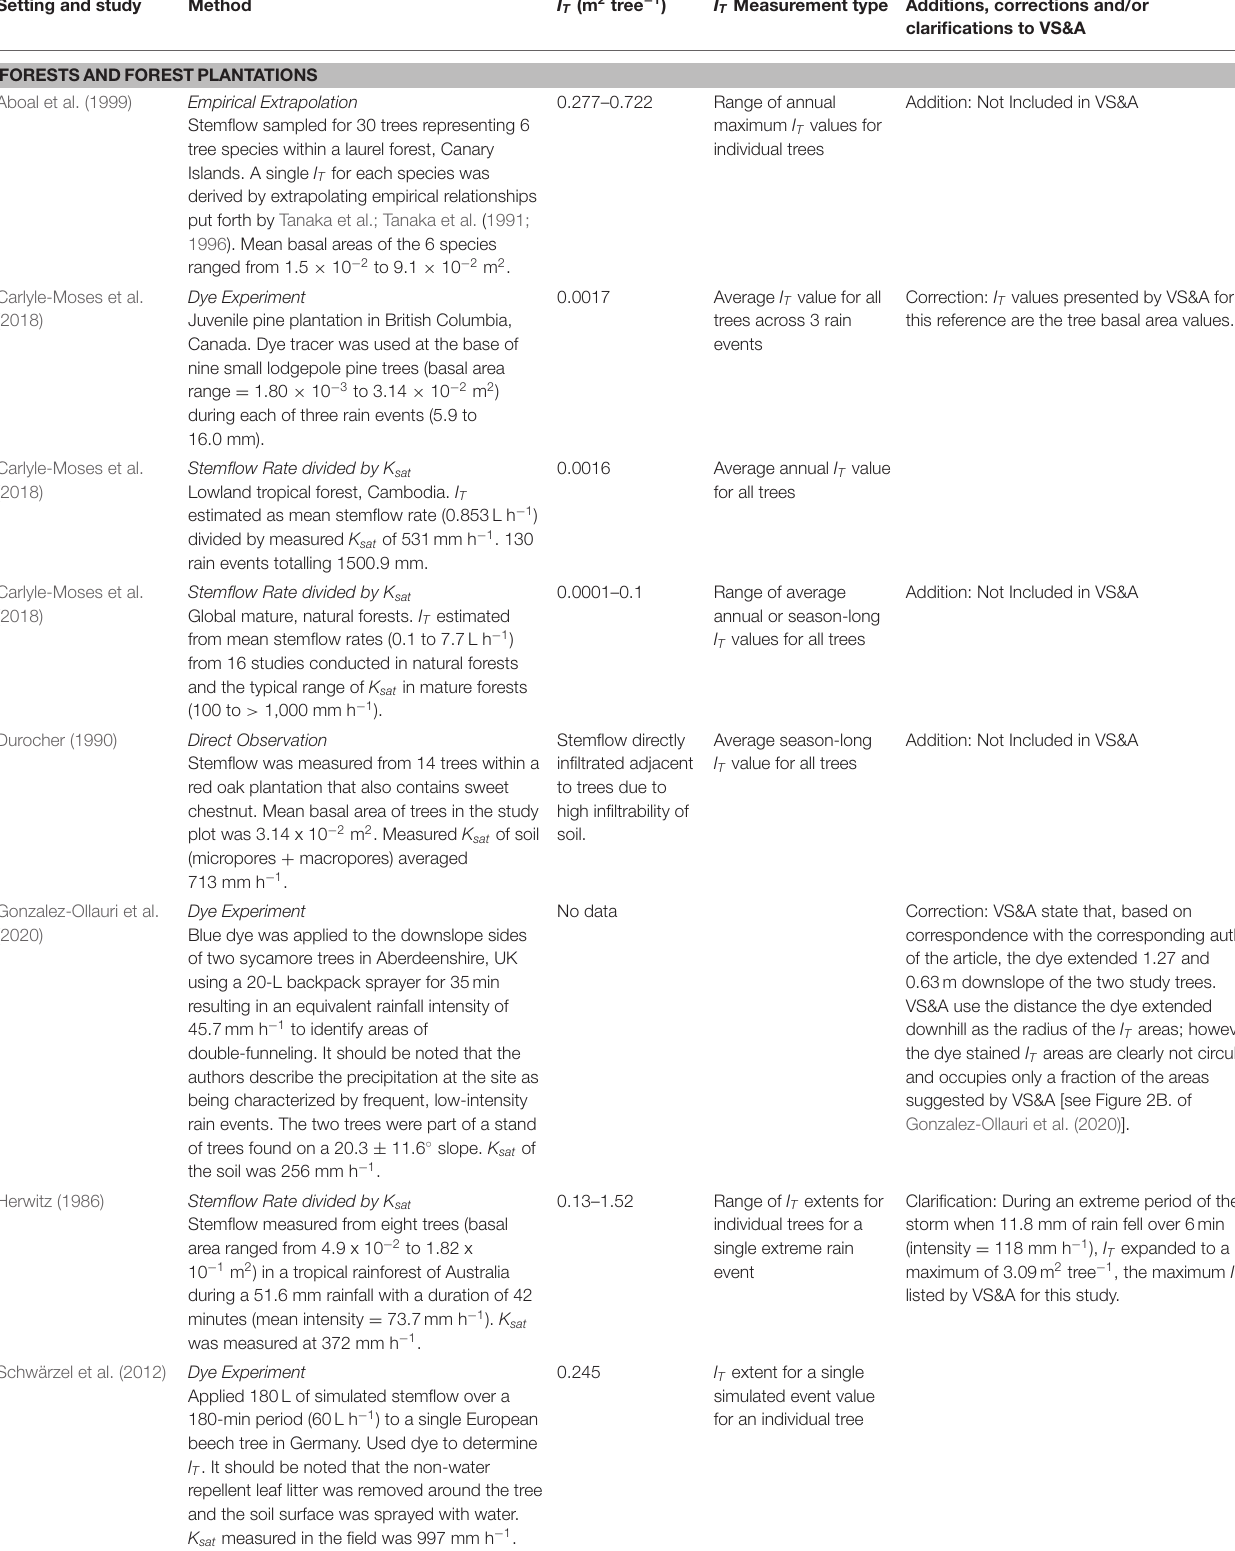
TABLE 1 | Stemflow infiltration areas ( I T ) from previous